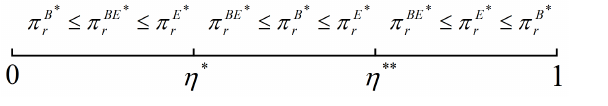
∗ ∗ ∗ , π E r and π BE r when x ≥ 1.